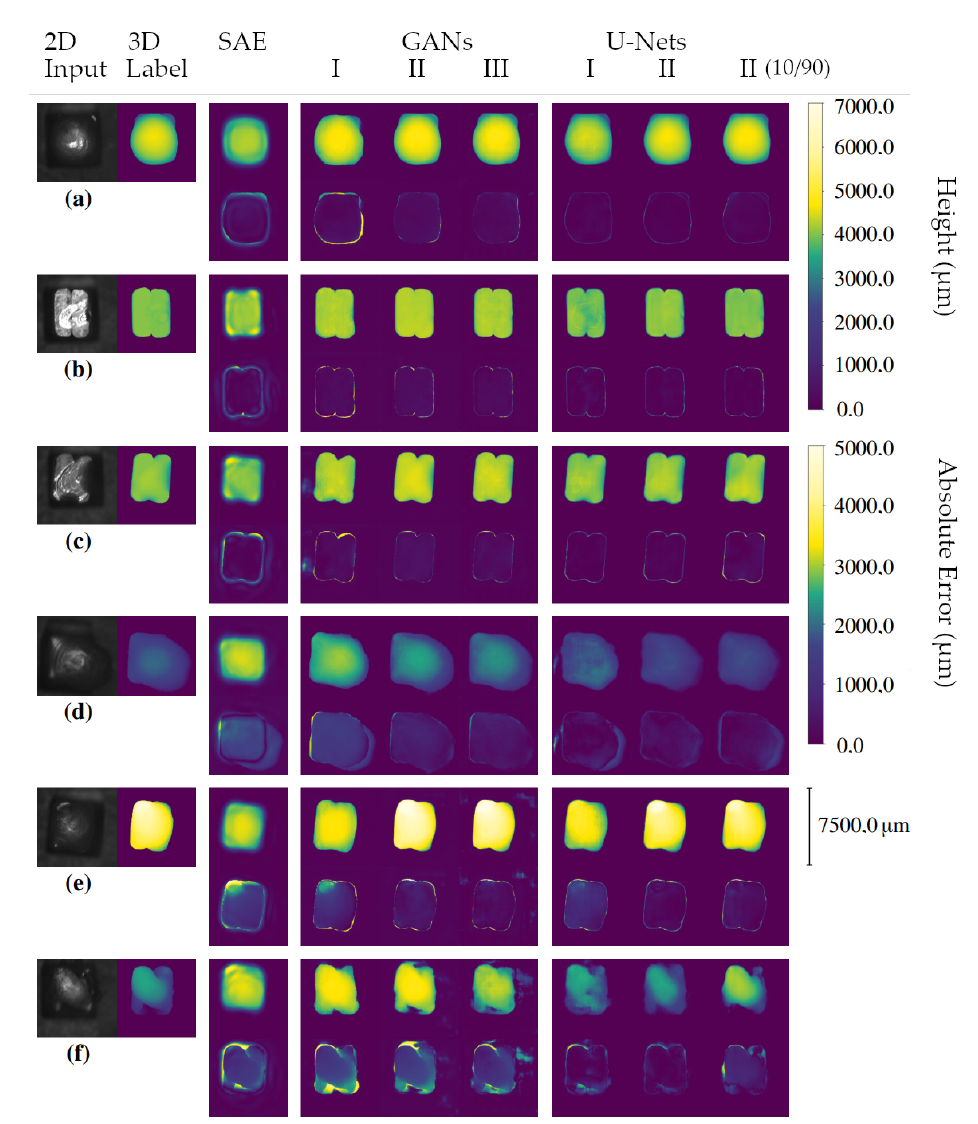
Figure 5. Three-dimensional reconstruction results of test input images. The reconstruction results of different input hairpins are shown: ( a ) good welding, ( b ) hairpin not in focus of laser, ( c ) welding with too little power, ( d ) welding with too much power, ( e ) hairpin with offset of copper rods and ( f ) copper rods without removed insulation. In each case, the first line shows the reconstruction and the second line shows the absolute error between label and reconstruction. The test sample numbers from ( a – f ) are 1, 47, 53, 130, 44 and 48. Figure 4 thus allows the determination of the